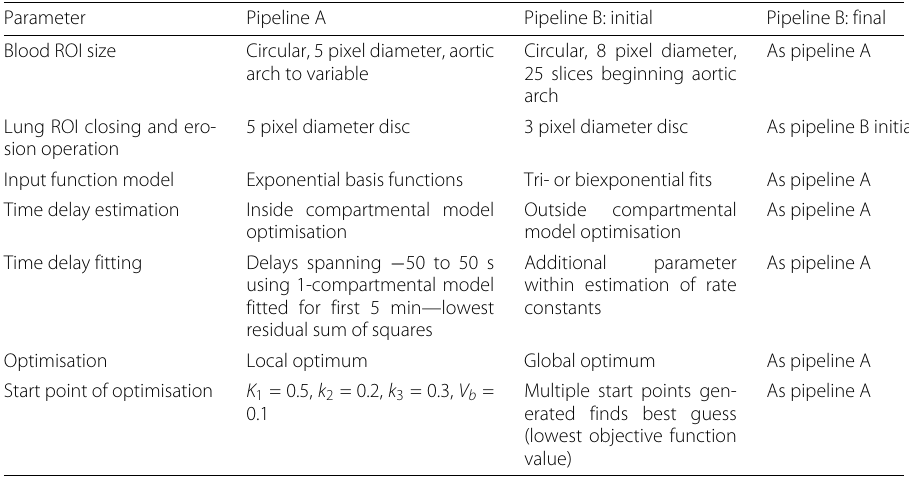
Table 1 Comparison of two analysis pipelines used to estimate metabolic rate of 18 F-FDG to assess pulmonary